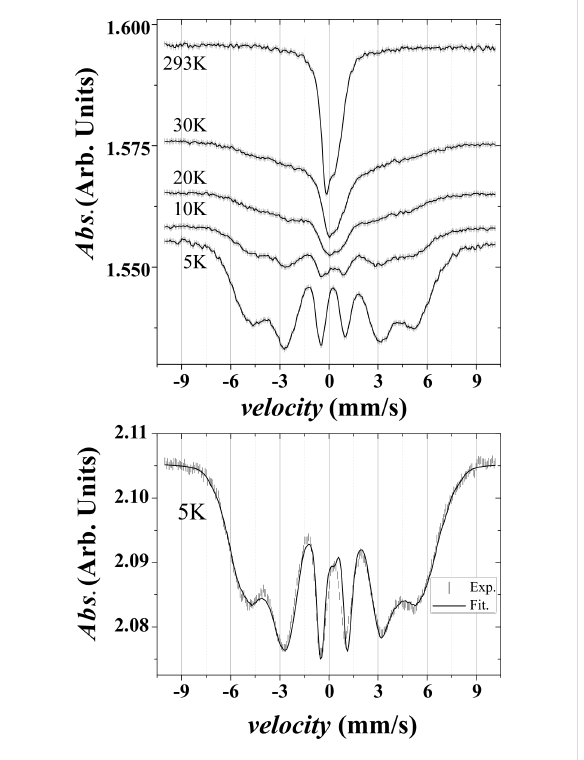
Figure 4: Top: Mössbauer spectra taken at different temperatures. Bottom: experimental spectra (symbols) taken at 5 K and the corres- ponding fit (solid